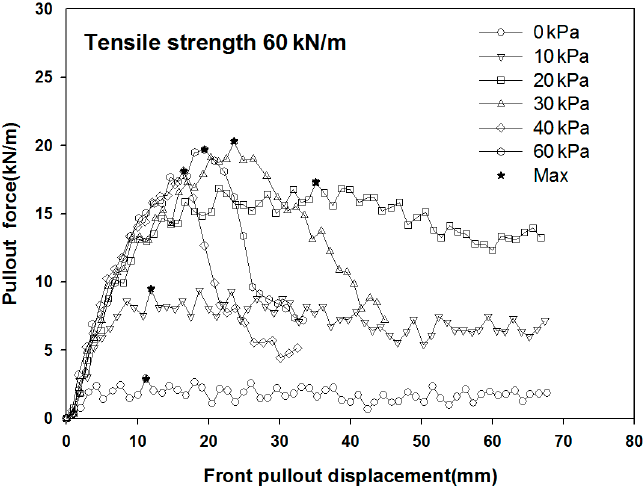
Figure 5. Front pullout displacement versus pullout force with confining stress (T g = 60 kN/m).